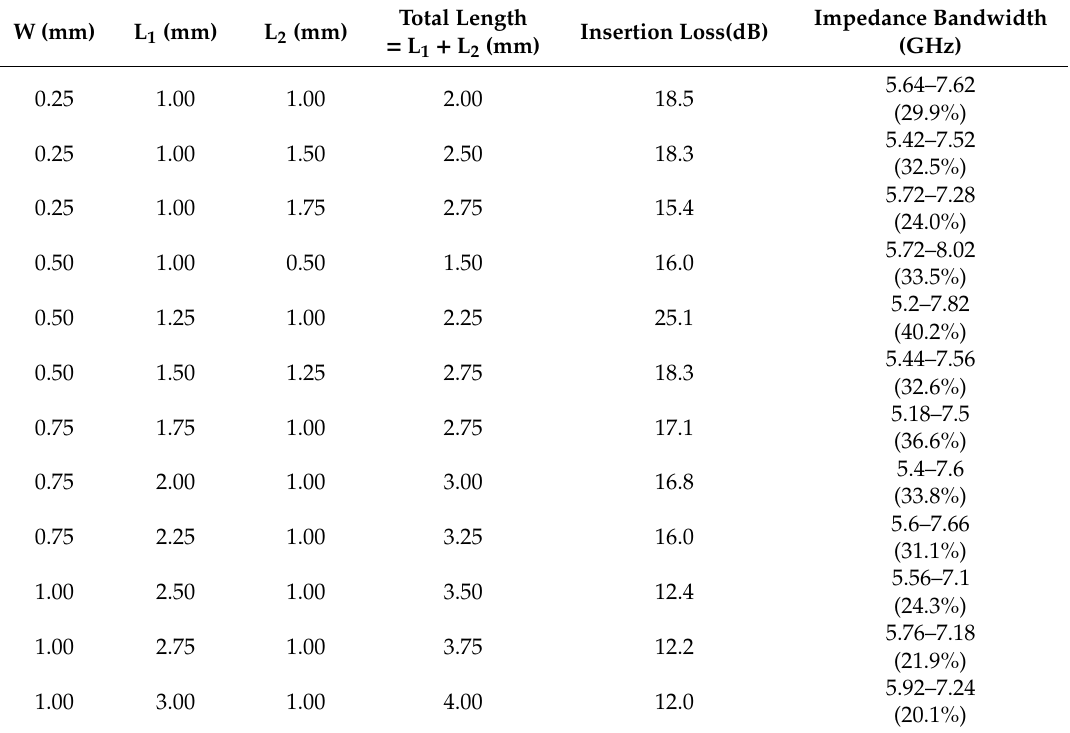
Table 1. Geometric parameters, insertion losses, and impedance bandwidths of the modified SRR for 6.5 GHz brain-to-probe